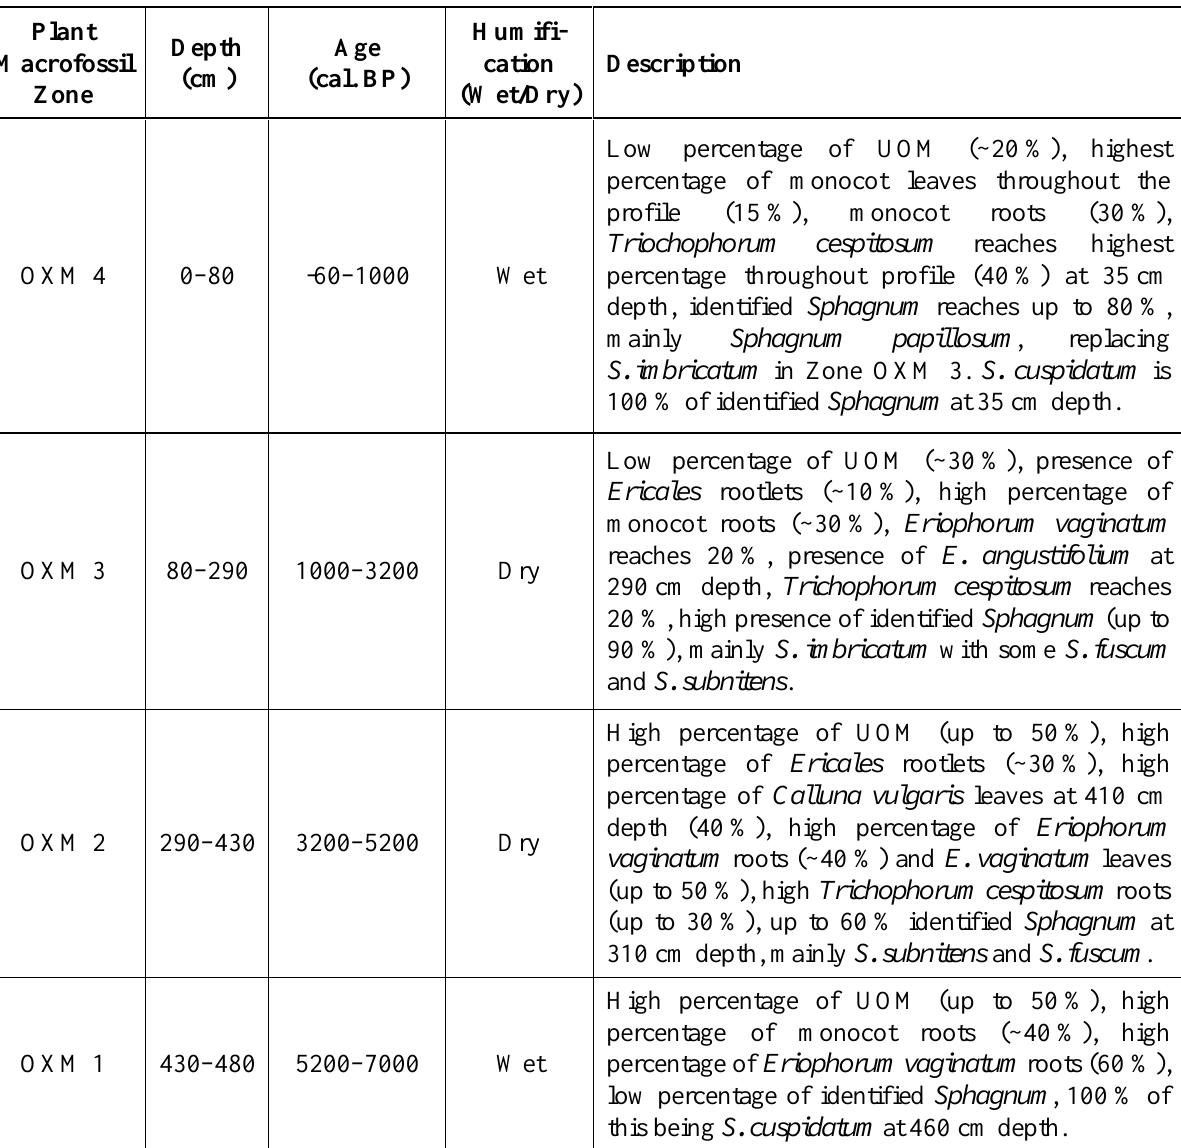
Table 3. Plant macrofossil zone descriptions using depth (cm), radiocarbon ages (cal. BP) and humification